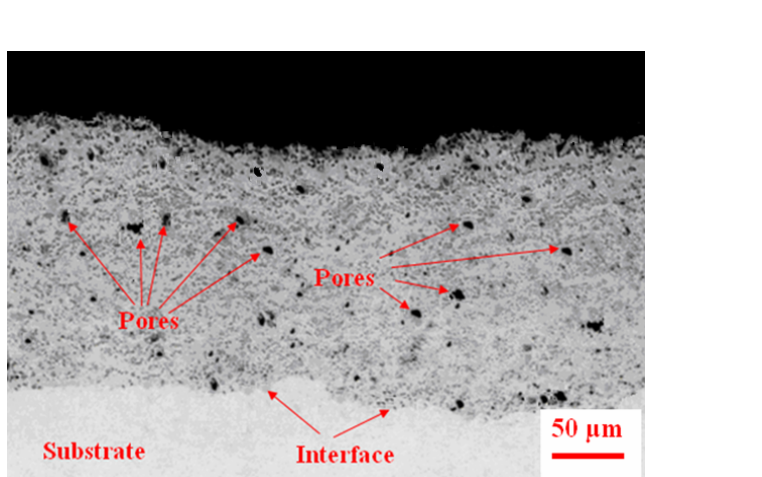
Figure 4 – Microstructure of the WC – 12wt.%Co coating deposited with